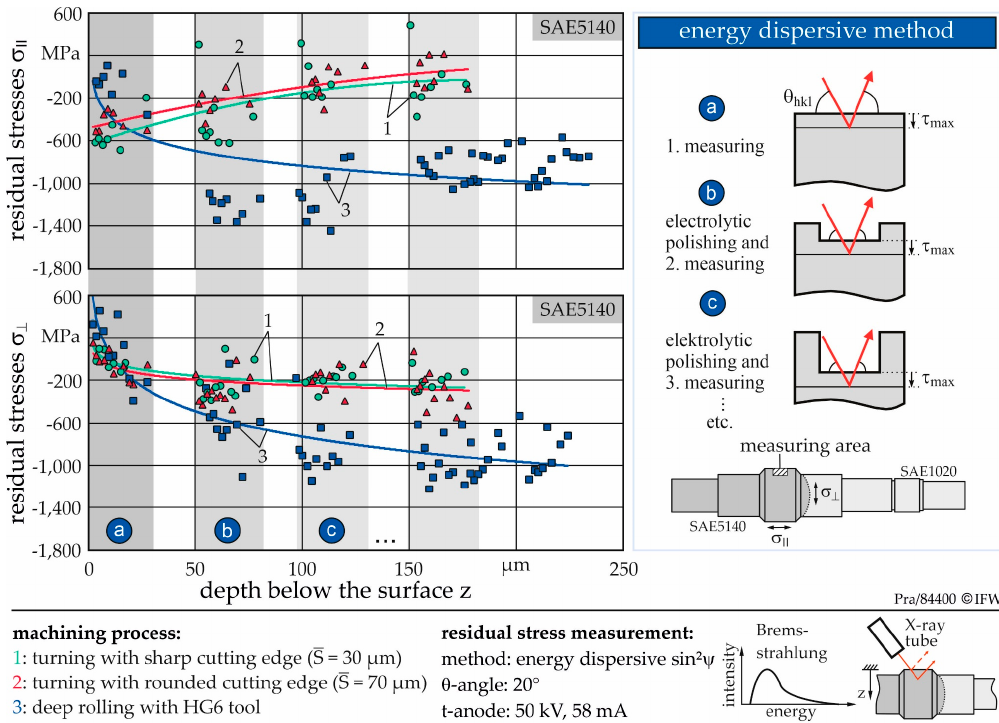
Figure 7. Influence of different manufacturing processes on the residual ‐ stress depth profile measured with the energy dispersive method combined with electrolytic polishing ( a – c ).